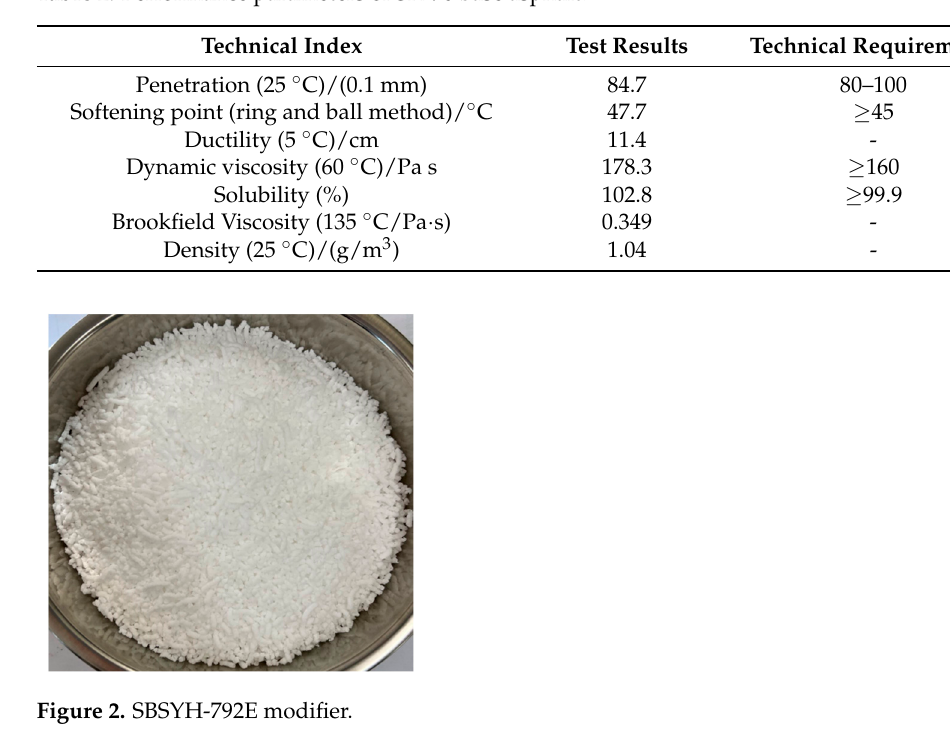
Table 3. Basic Physical Properties of RPP.